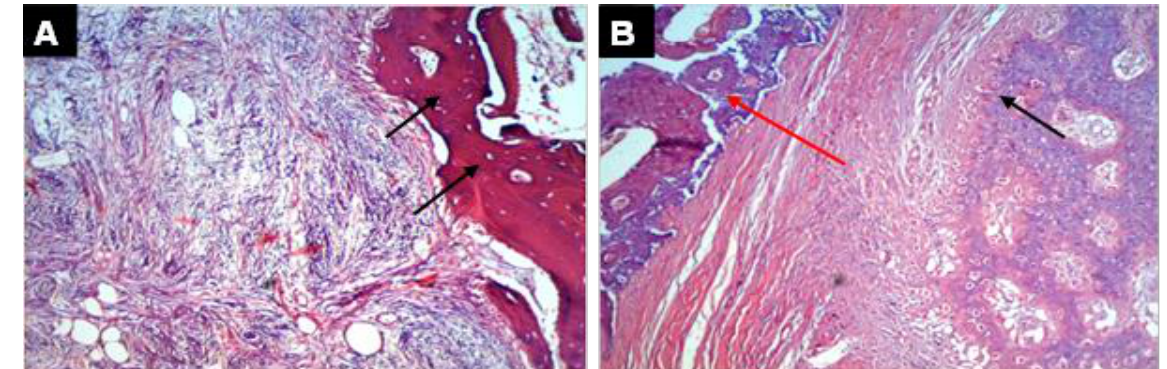
Figure 6. Histopathological section in control group at 12 th weeks post-operation, (A) thickness trabecular bone and lamellar bone at the end of defect bone extended into granulation tissue (arrows). (B) a new bone connective tissue (red arrow) and cartilaginous formation(black arrow) (H and E, 100×)